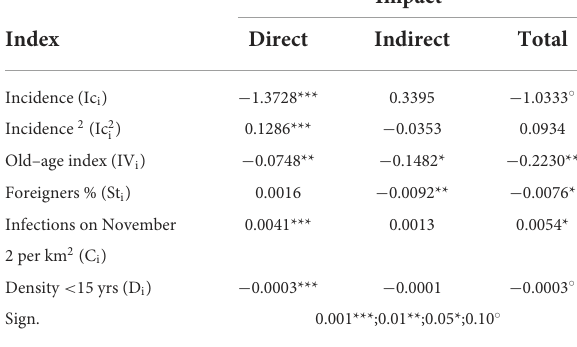
TABLE 3 Breakdown of the spatial